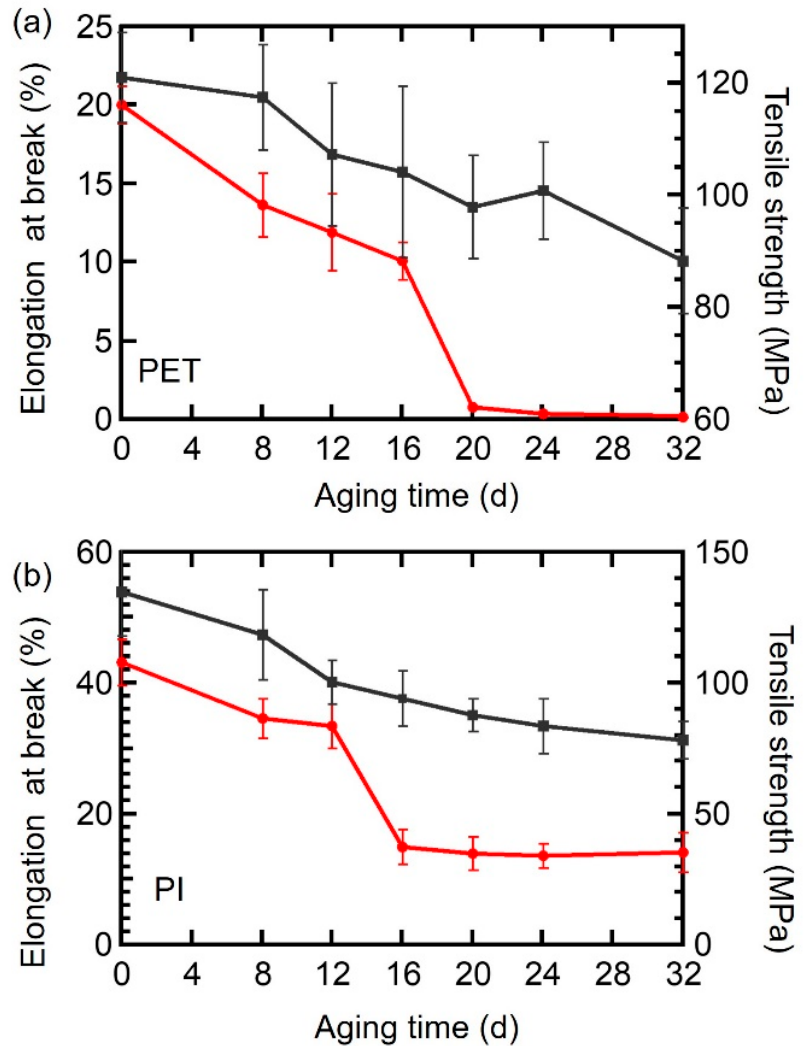
Figure 6. Influence of hydrothermal aging time on mechanical properties of PET ( a ) and PI ( b )